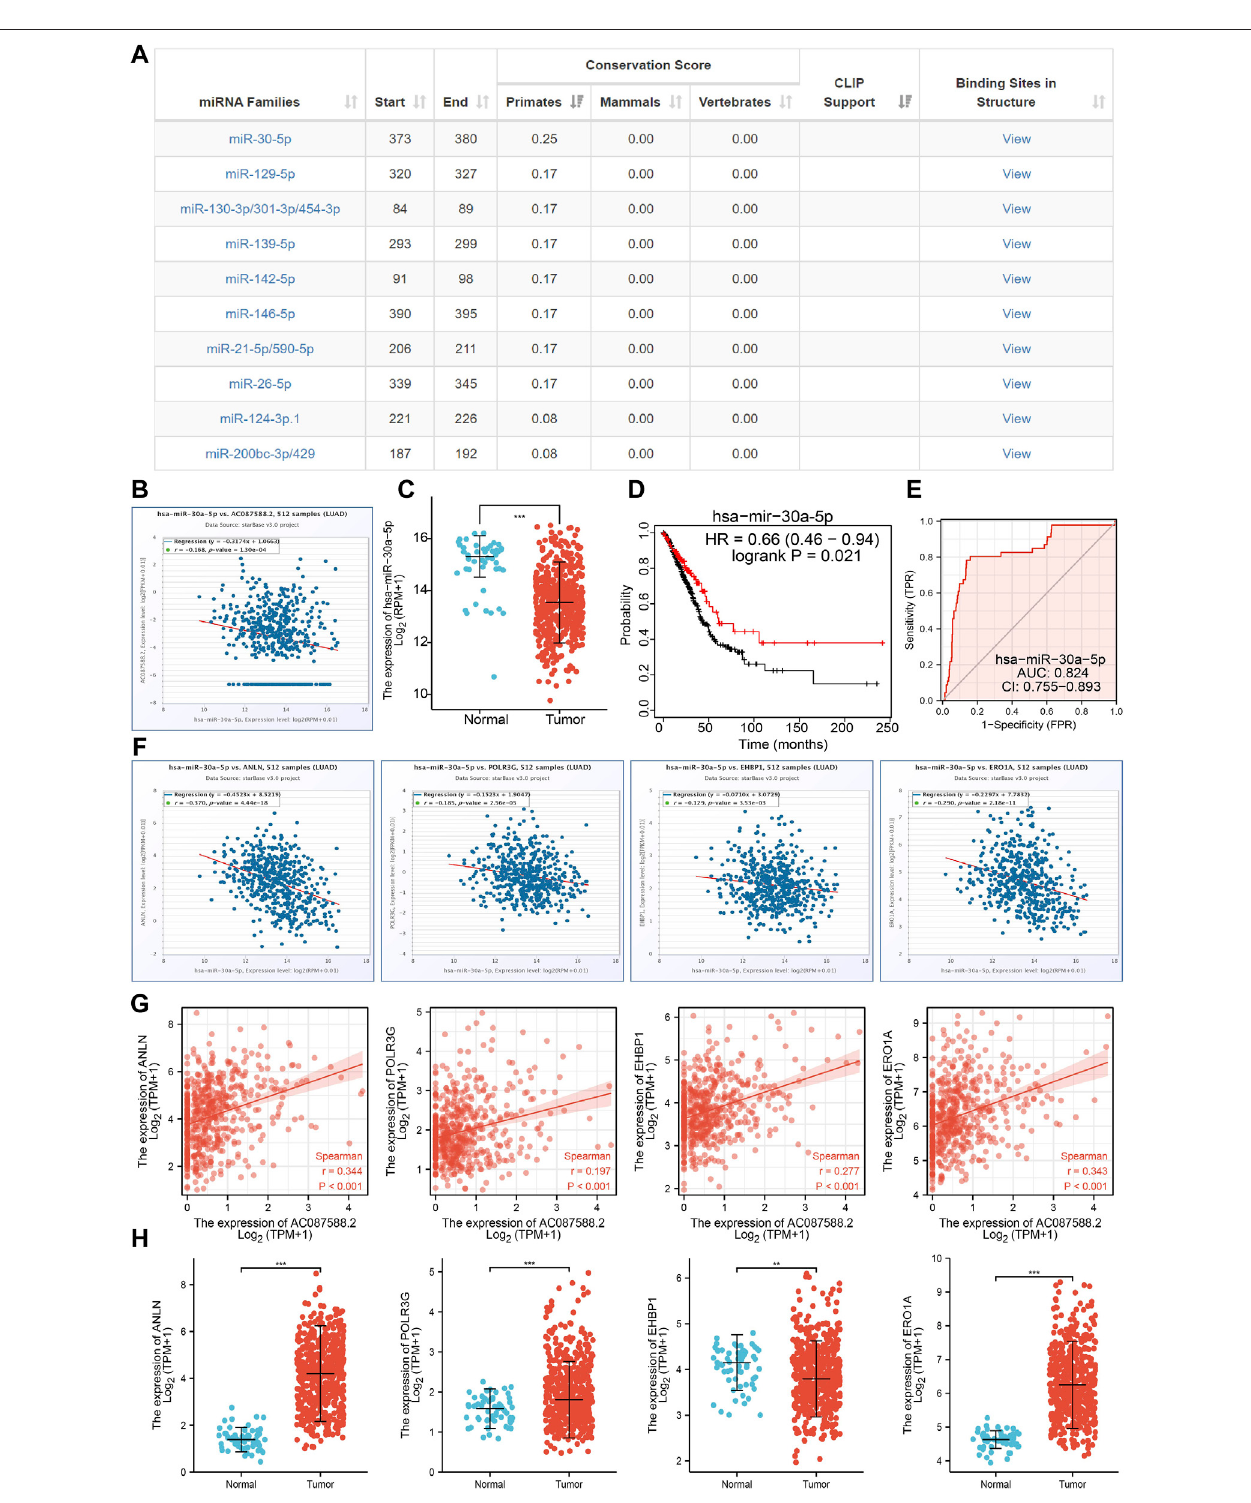
FIGURE 9 | Analysis of the potential miRNAs of AC087588.2. (A) Potential miRNAs of AC087588.2 determined by the Anbolnc2 database. (B) . Correlations between AC087588.2expression and miR-30a-5p in LUAD. (C) Expression level of miR-30a-5p in LUAD. (D) Overall survival ofmiR-30a-5p in LUAD. (E) ROC curveof miR-30a-5p in LUAD. (F) Correlations between the miR-30a-5p expression and ANLN, POLR3G, EHBP1, and ERO1A in LUAD. (G) Correlations between the AC087588.2 expression and ANLN, POLR3G, EHBP1, and ERO1A in LUAD. (H) RNA level of ANLN, POLR3G, EHBP1, and ERO1A in LUAD.